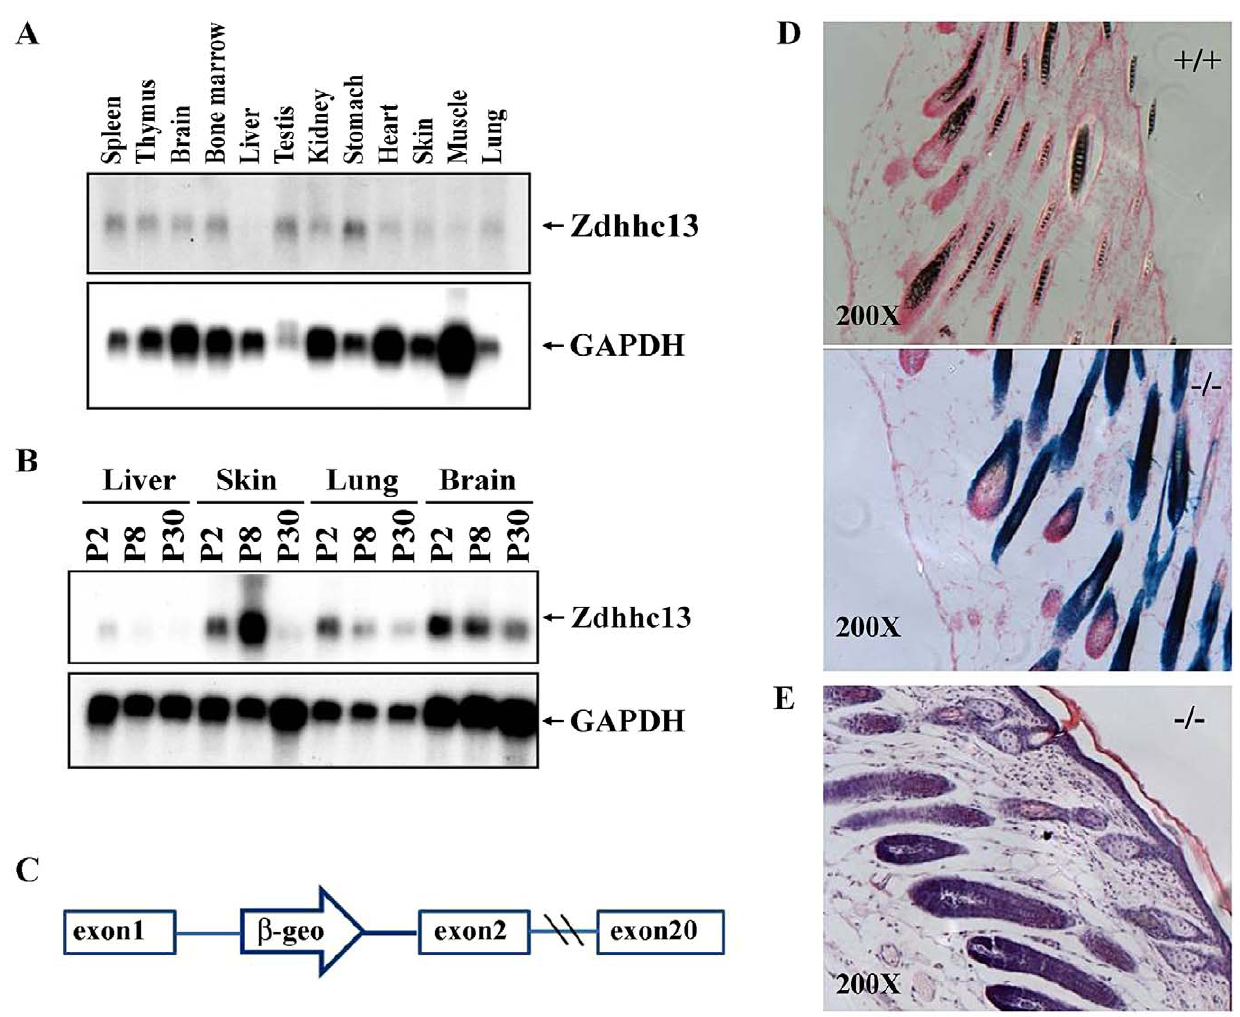
Figure 9. Expression of Zdhhc13 . (A) Expression of Zdhhc13 in normal adult tissues. GAPDH was used as a loading control, (B) Expression of Zdhhc13 in liver, skin, lung and brain at postnatal (P) days 2, 8, and 30. Again, GAPDH was used as a control, (C) A gene trap vector insertion in intron 1 of Zdhhc13 . The open arrow containing a b -geo cassette indicates the location of the gene trap vector, (D) Xgal staining of the p10 gene trap mutant and wild type. Note protein expression in the epithelium of the hair follicles. Sections were counterstained with nuclear fast red. The magnification is 200 6 , (E) Histopathology of gene traps mice skin, showing the abnormal follicles, lack of hair and thickened epidermis which are similar to ENU mutant mice.